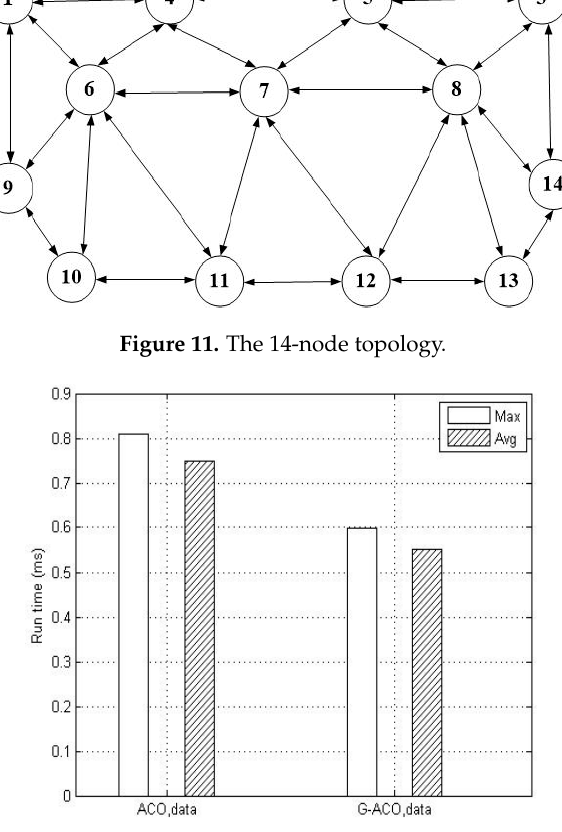
Figure 12. The comparison of running time with the 14-node topology.